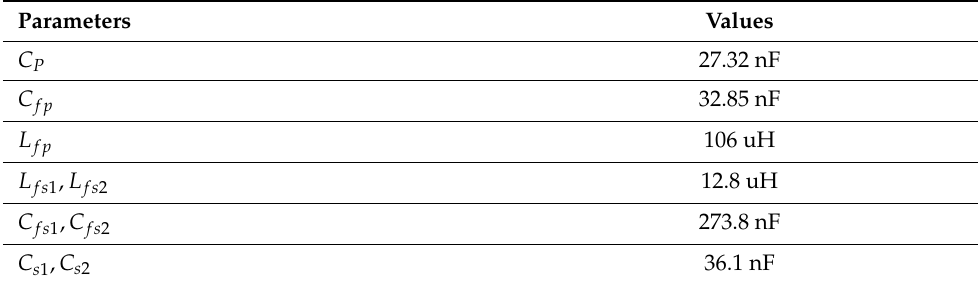
Table 11. Compensation parameters for 48 V IPT